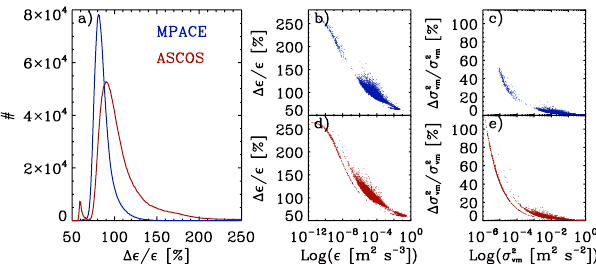
Fig. 3. Distributions of the theoretical fractional error in dissipation rate calculated using Eq. (7) (a) , relationships between dissipation rate and the fractional error in dissipation rate ( b and d ), and rela- tionships between the velocity variance and the fractional error in velocity variance ( c and e ) for all valid dissipation rate retrievals on the comparison days use in this study. In all cases, red represents ASCOS results while blue represents MPACE